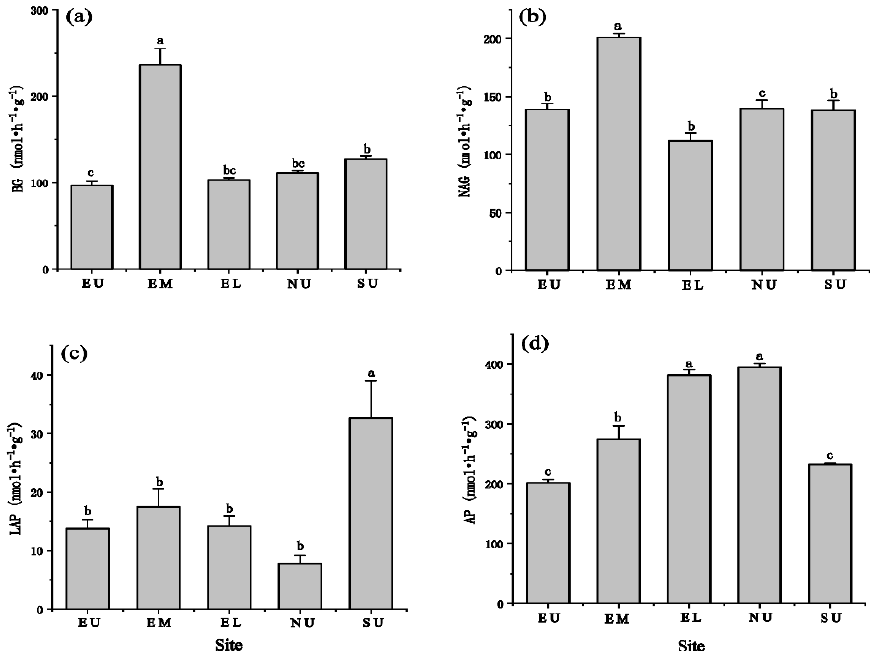
Figure 2. Soil extracellular enzyme activity under different site conditions. SU, the upper slope of the south; NU, the upper slope of the north; EU, the upper slope of the east; EM, the middle slope of the east; EL, lower slope of the east. BG, β – glucosidase ( a ); NAG, β – 1,4 – N – acetylglucosaminidase ( b ). LAP, leucine aminopeptidase ( c ); AP, acid phosphatase ( d ); Significant differences are marked by lowercase letters ( p < 0.05).